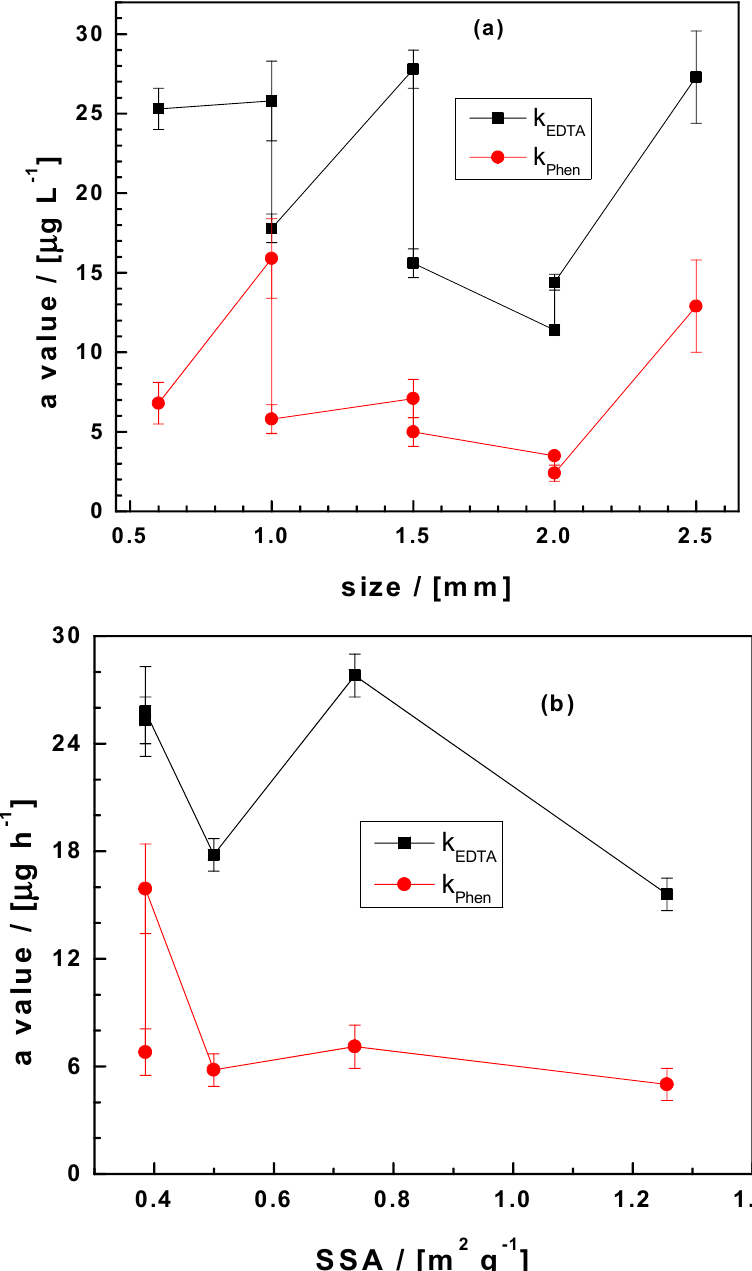
Figure 5. Changes of the ‘a’ value for both EDTA and Phen tests as influenced by: ( a ) the particle size, and ( b ) the specific surface area (SSA). Each sample is represented by its mean particle size or it is SSA (Table 1). Error bars denote the standard error for triplicate experimental results. Experimental conditions: V = 50 mL, m ZVI = 0.1 g. The lines are not fitting functions, they simply connect points to facilitate visualization.